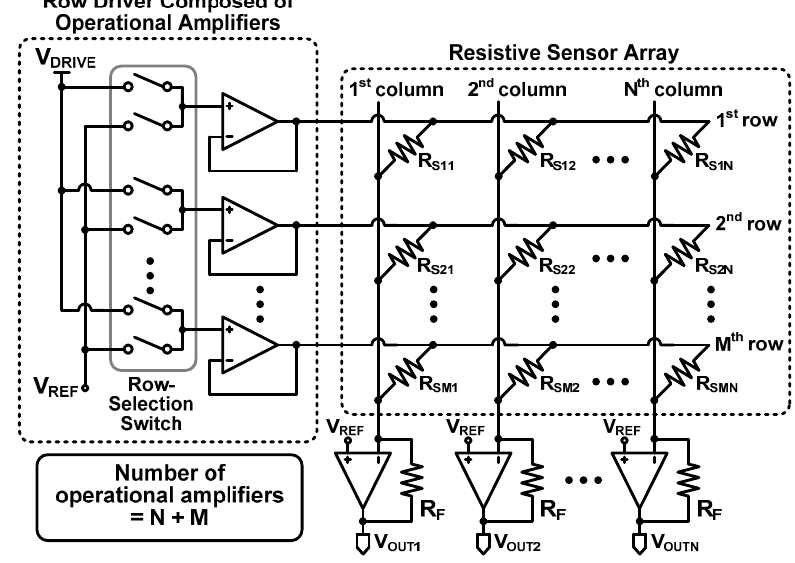
Figure 5. Zero-potential scanning method with a row driver composed of operational amplifiers (Type II). (Type II).